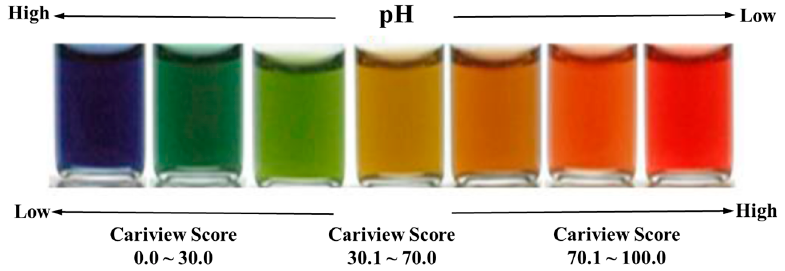
Figure 1. The scales for the Cariview criteria according to the pH value.